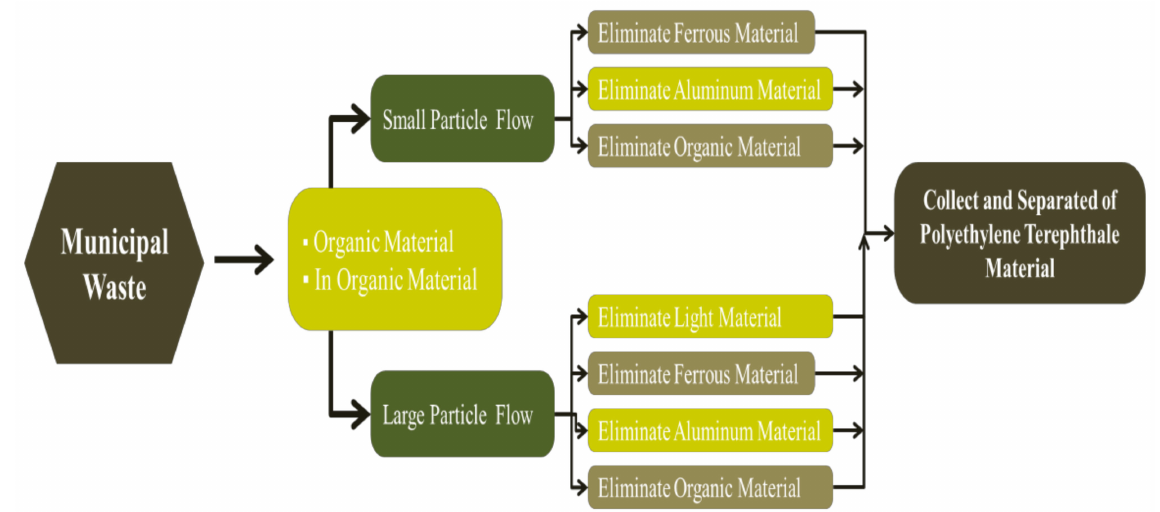
Figure 3. The classification of the conventional process to screen ferrous, aluminum and organic materials and collect